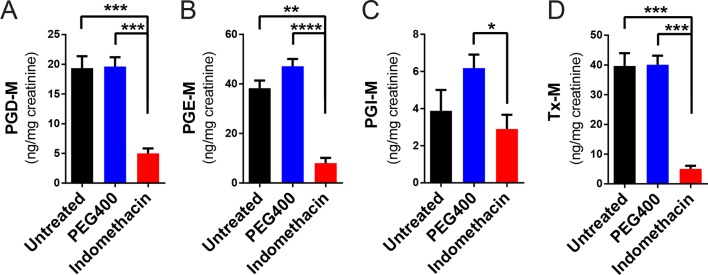
Inhibitory effects of acute indomethacin treatment on COX-1 and COX-2 in C57BL/6 mice.Mice were administered by gavage with or without 10 mg/kg indomethacin (red) or PEG400 (blue) and urine were collected for the analysis of prostanoid metabolites. PGD-M (A), PGE-M (B), PGI-M (C), and Tx-M (D) are reduced in indomethacin-treated mice. N=6/group. *p<0.05, **p<0.01, ***p<0.001, ****p<0.0001 by Mann-Whitney test, multiplicity adjusted. Mean ± S.E.M. shown.